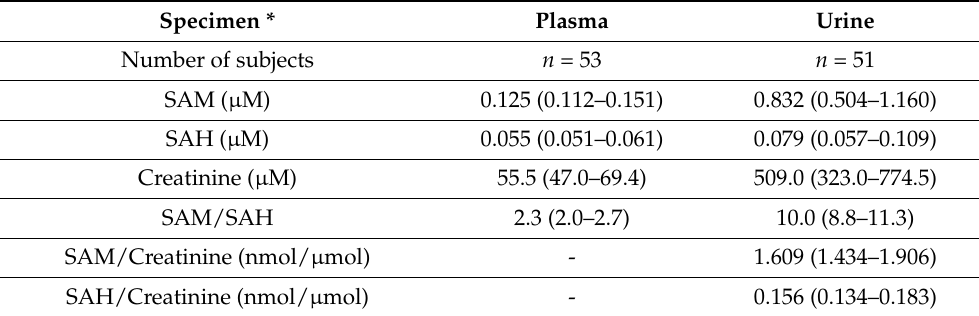
Table 3. Concentration of plasma SAM, SAH, and creatinine in healthy adult subjects at the start of the trial (baseline, omnivorous diet). Data are shown as median (1st quartile–3rd quartile).